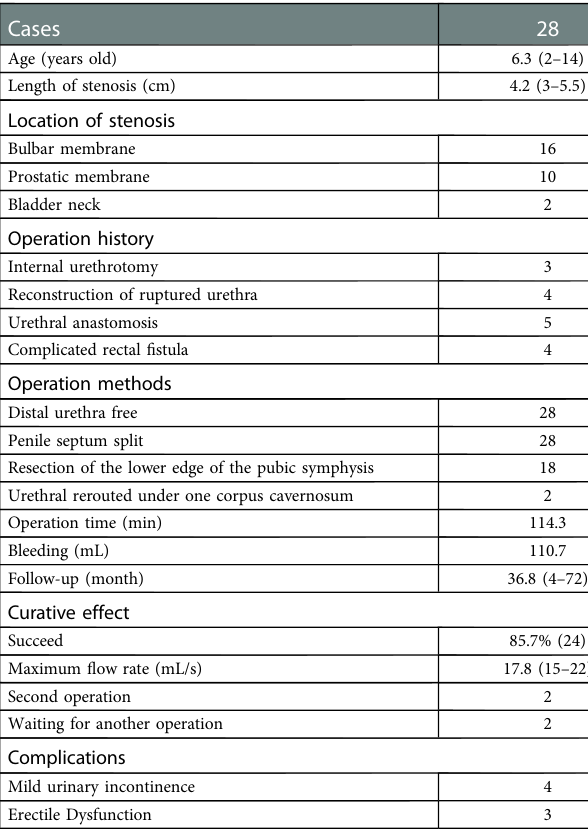
TABLE 1 Demographics and clinical data of the 28 patients with complicated posterior urethral stricture.